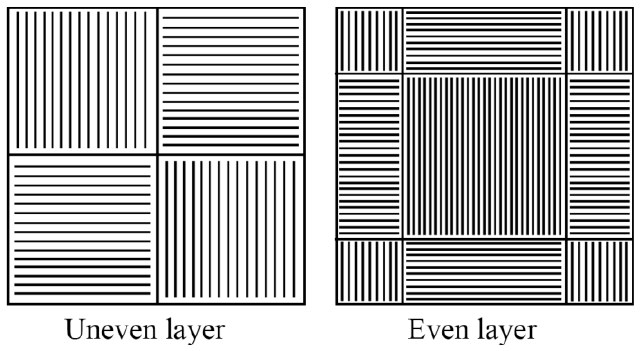
Figure 3. Scanning strategy of the dense LPBF